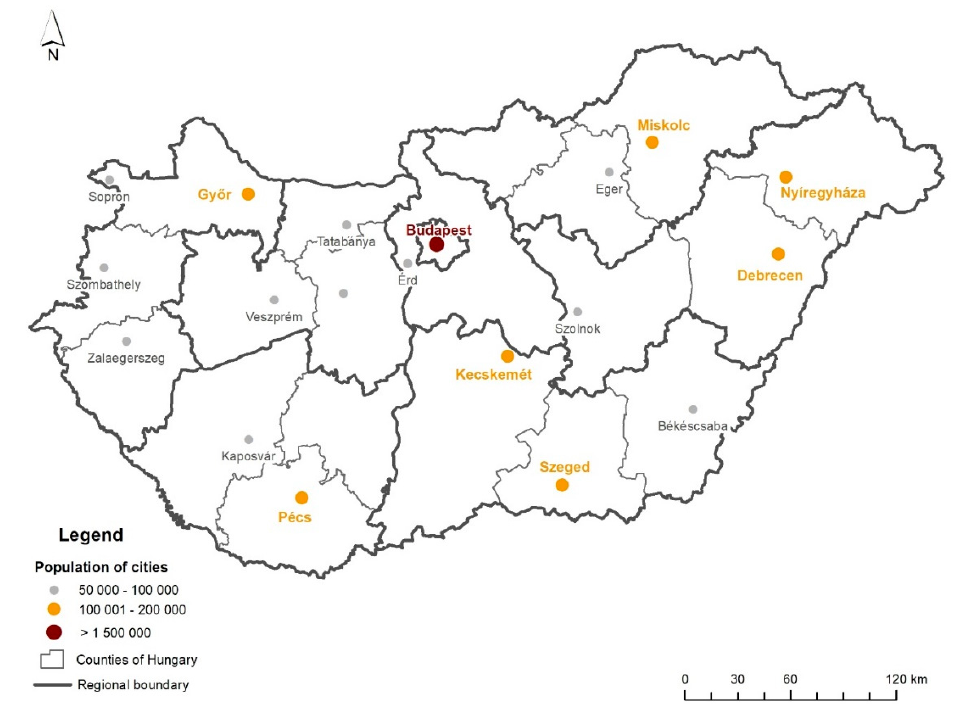
Figure 5. The Hungarian cities with population exceeding 50,000 inhabitants.